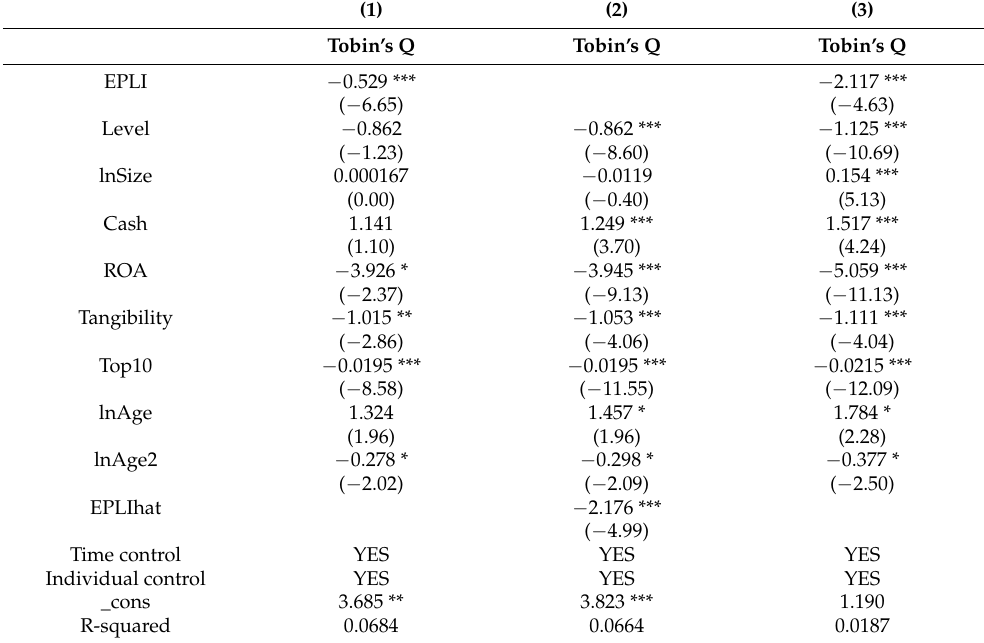
Table 6. Robustness test for bootstrap and cluster robust standard